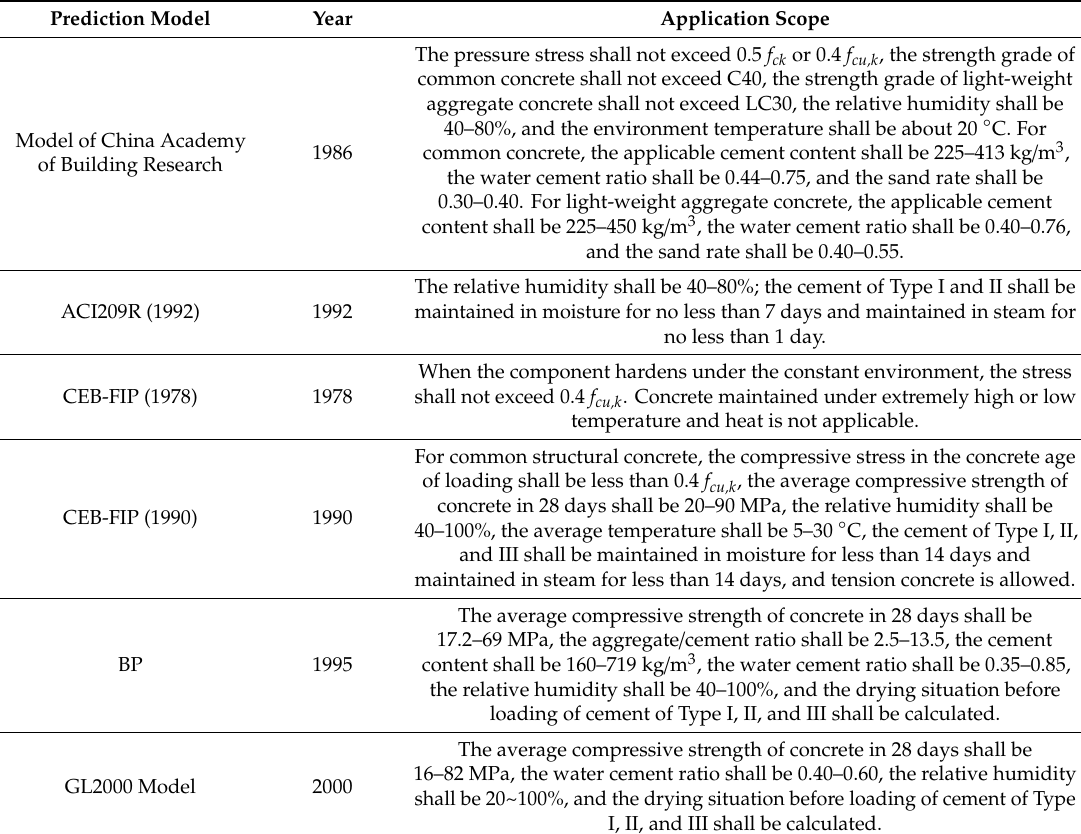
Table 8. Application scope of traditional model for predicting shrinkage and creep of concrete.